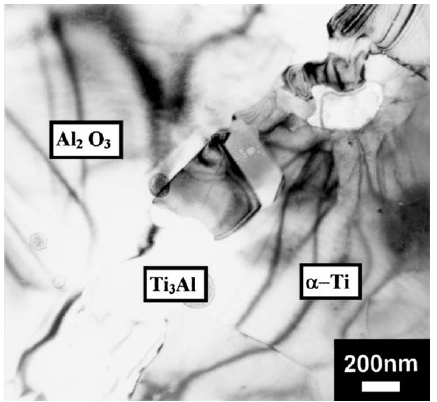
Figure 17. Transmission electron microscopy (TEM) image of the Ti/Al 2 O 3 obtained at 900 °C, reproduced from Reference [43] with permission of Springer, 2000.